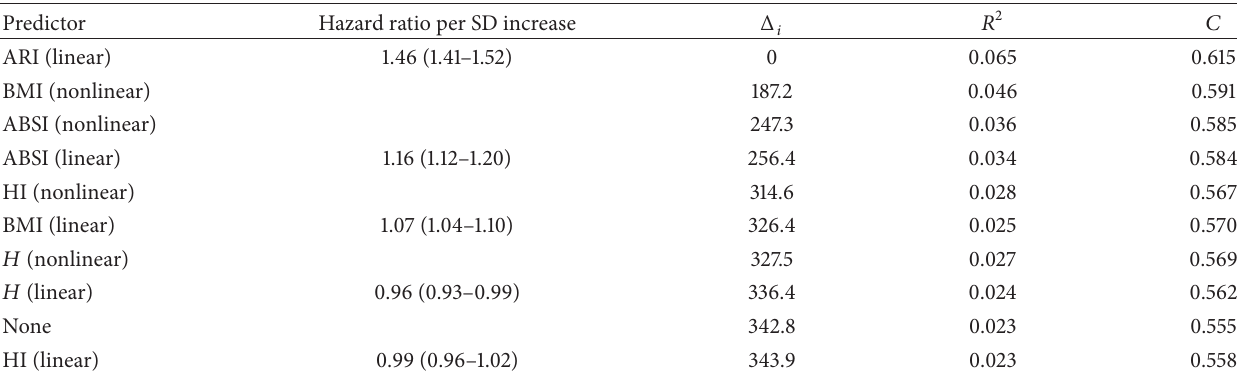
Table 4: Mortality hazard association with body measures in NHANES